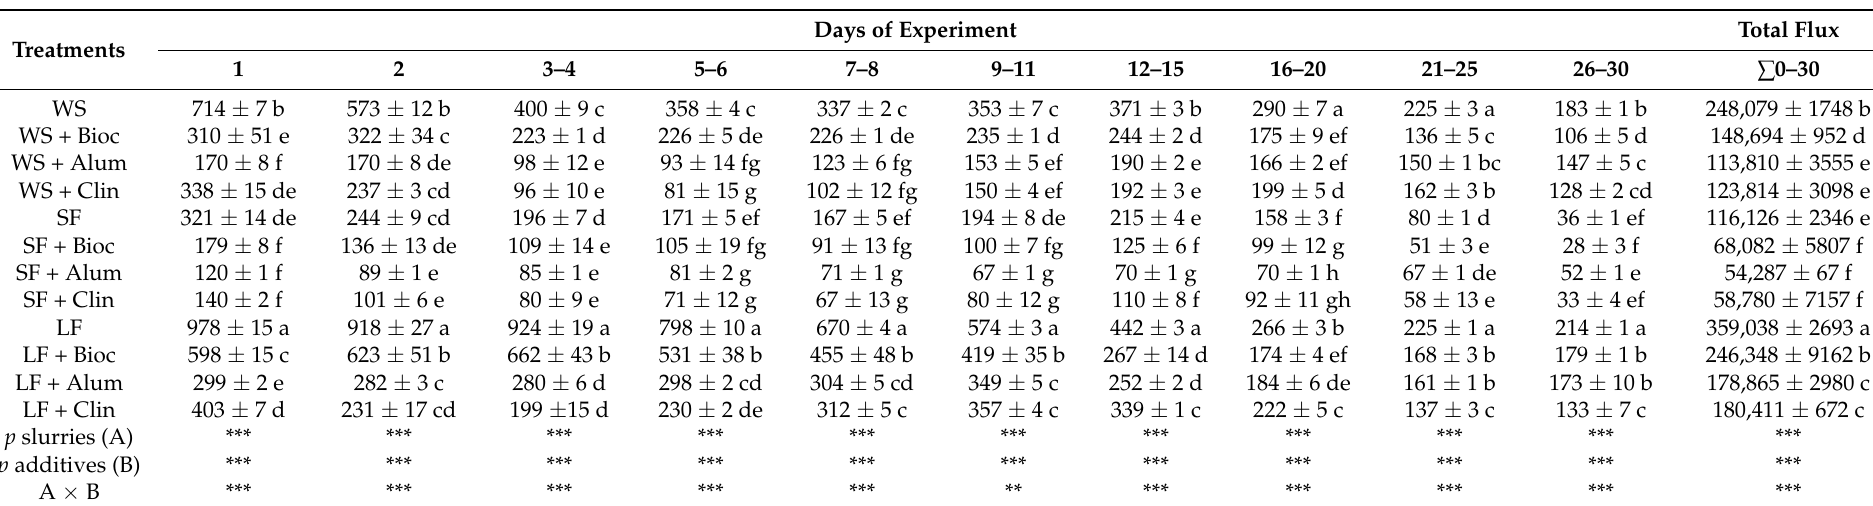
Table 2. Average ammonia fluxes (mg m − 2 h − 1 ) and total flux (mg m − 2 ) from each treatment (mean ± standard deviation) ( n = 3).